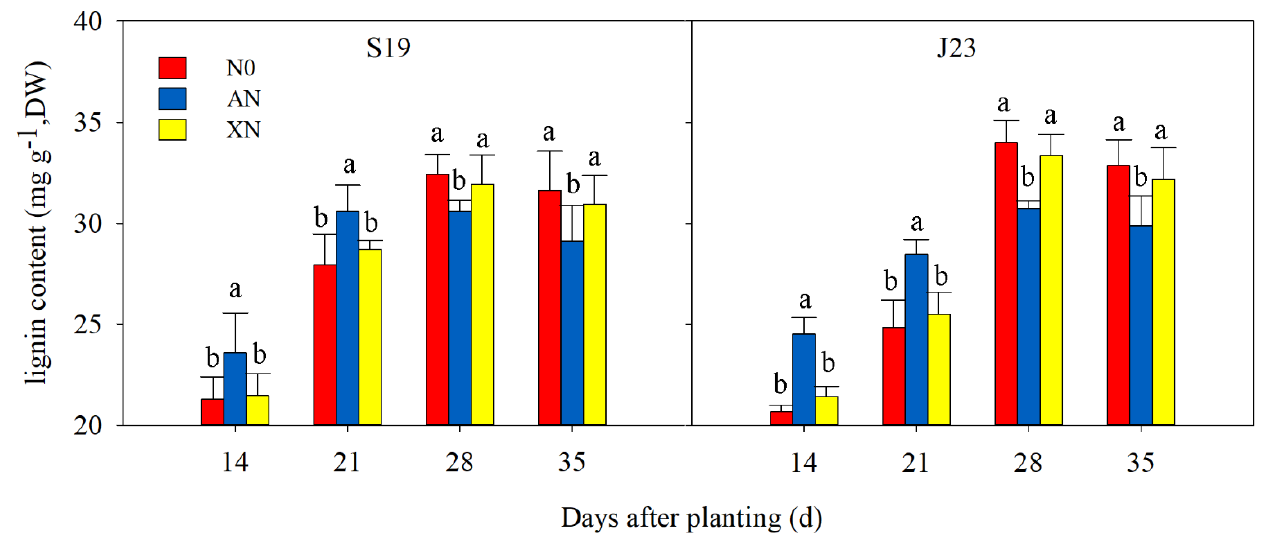
Figure 2. Changes in lignin content in potential storage roots of sweet potato during storage root formation. Note: N0, no nitrogen fertilizer; AN, ammonium nitrogen; XN, amide nitrogen. Error bars represent standard error of the mean (three biological repeats), and different letters (a and b) indicate significant differences between N treatments ( p < 0.05). Table 3. PAL and POD activity in potential storage roots of sweet potato during storage root formation. Days after